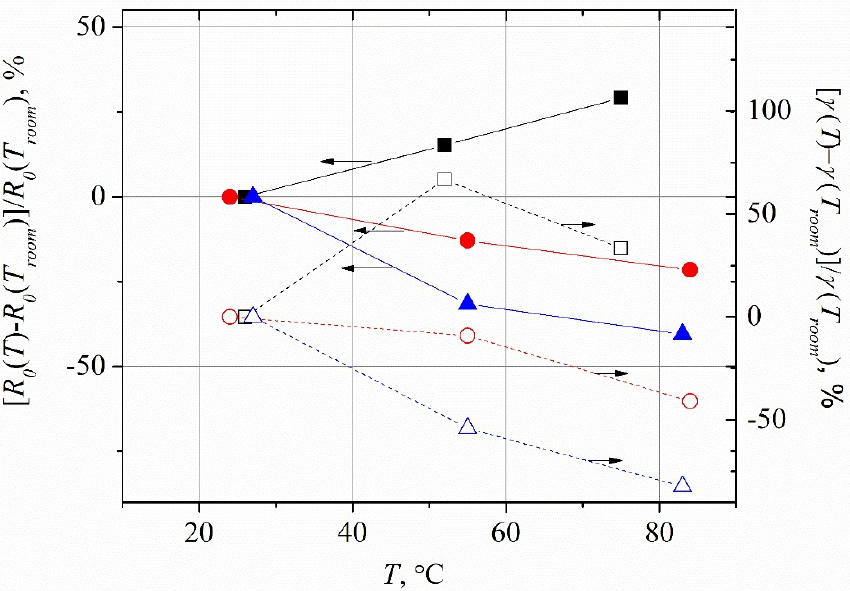
Figure 8. Temperature dependence of electrical resistance of the planar microwave diodes at zero applied voltage (solid dots), and temperature dependence of the non-linearity coefficient γ of the IV characteristics of the diodes at zero voltage (open dots). The colors correspond to the same type of the diodes as in Figure 7.